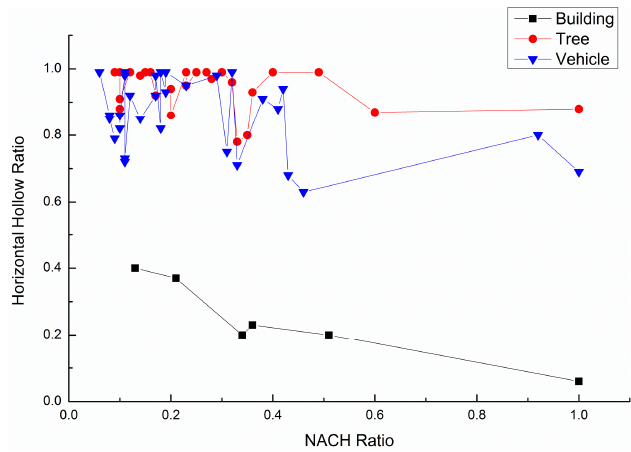
Figure 8. Horizontal hollow ratios of buildings, cars, and trees in Figure 6 (one point represents one object in Figure 6).